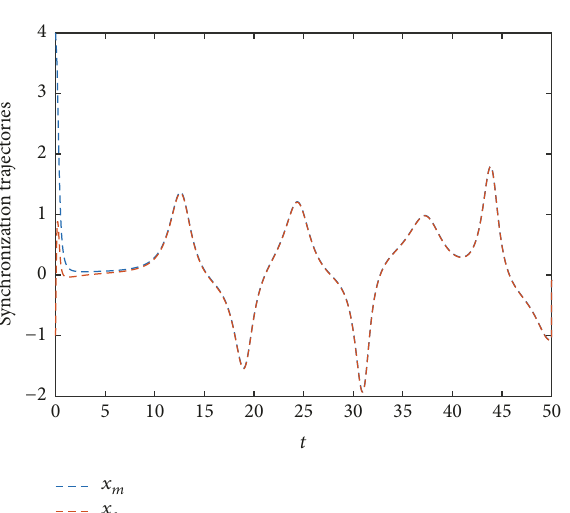
Figure 5: The synchronization trajectories of 𝑧 𝑚 , 𝑧 𝑠 .